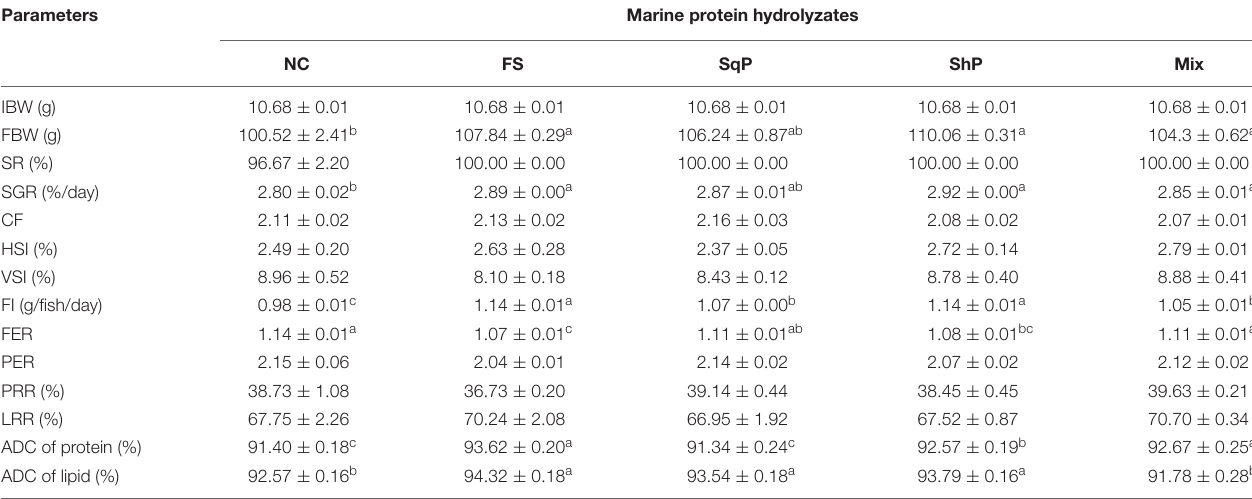
TABLE 5 | Growth performance and feed utilization of largemouth bass fed the experimental diets for 81 days*. Parameters Marine protein